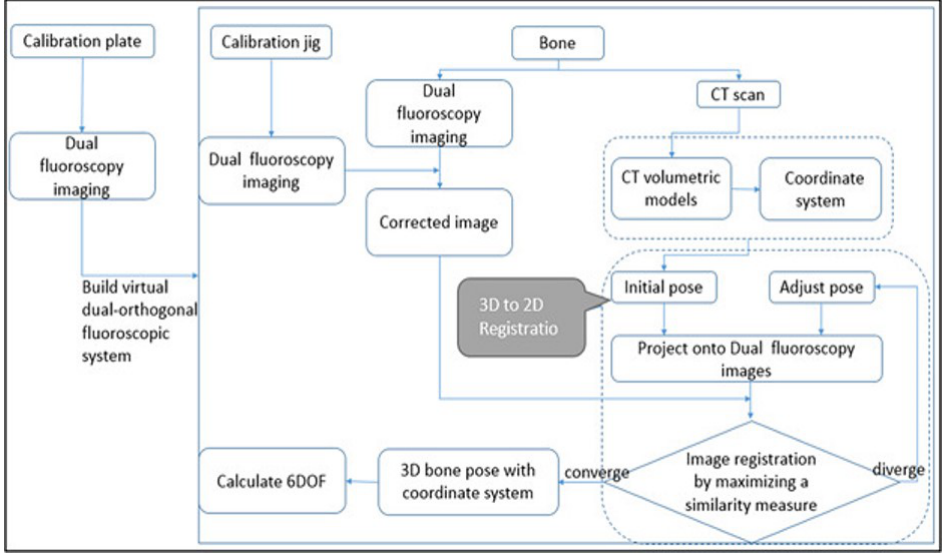
Figure 6. Block diagram of the 3D-to-2D re-projection